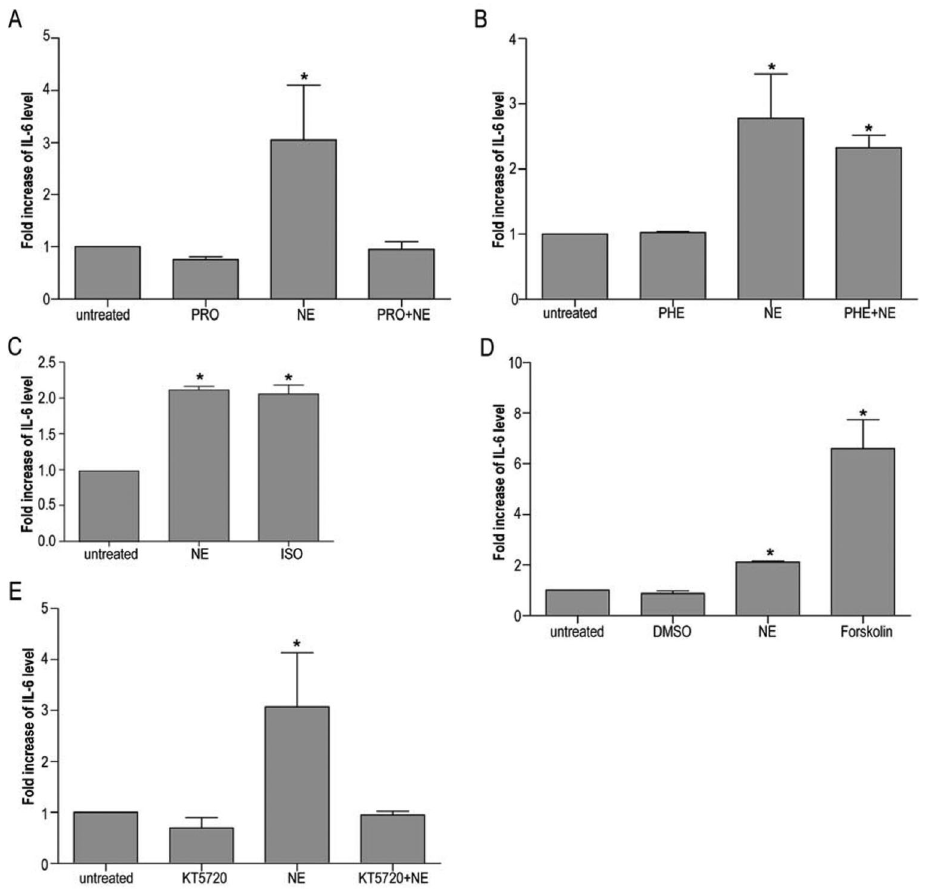
Figure 3. Assessment of the role of b -adrenergic receptors-cAMP-PKA pathway in norepinephrine (NE)-induced IL-6 expression of GES- 1 cells. A , ELISA assay measuring IL-6 after treatment with 10 m M NE, 10 m M propranolol (PRO), 10 m M NE plus PRO (PRO++NE). B , ELISA assay measuring IL-6 after treatment with 10 m M NE, 10 m M phentolamine (PHE), 10 m M NE plus PHE (PHE++NE). C , ELISA assay measuring IL-6 after treatment with 10 m M NE, 10 m M isoproterenol (ISO). D , ELISA assay measuring IL-6 after treatment with DMSO, 10 m M NE, 10 m M forskolin. E , ELISA assay measuring IL-6 after treatment with 10 m M NE, 10 m M KT5720 and 10 m M NE plus 10 m M KT5720 (KT5720++NE). Data are reported as means±SE. *P , 0.05, compared to control